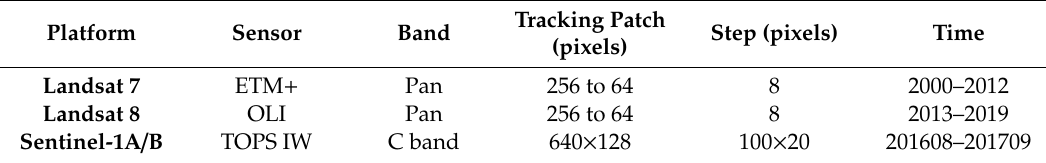
Table 1. Multiple sensors for glacier terminus and surface